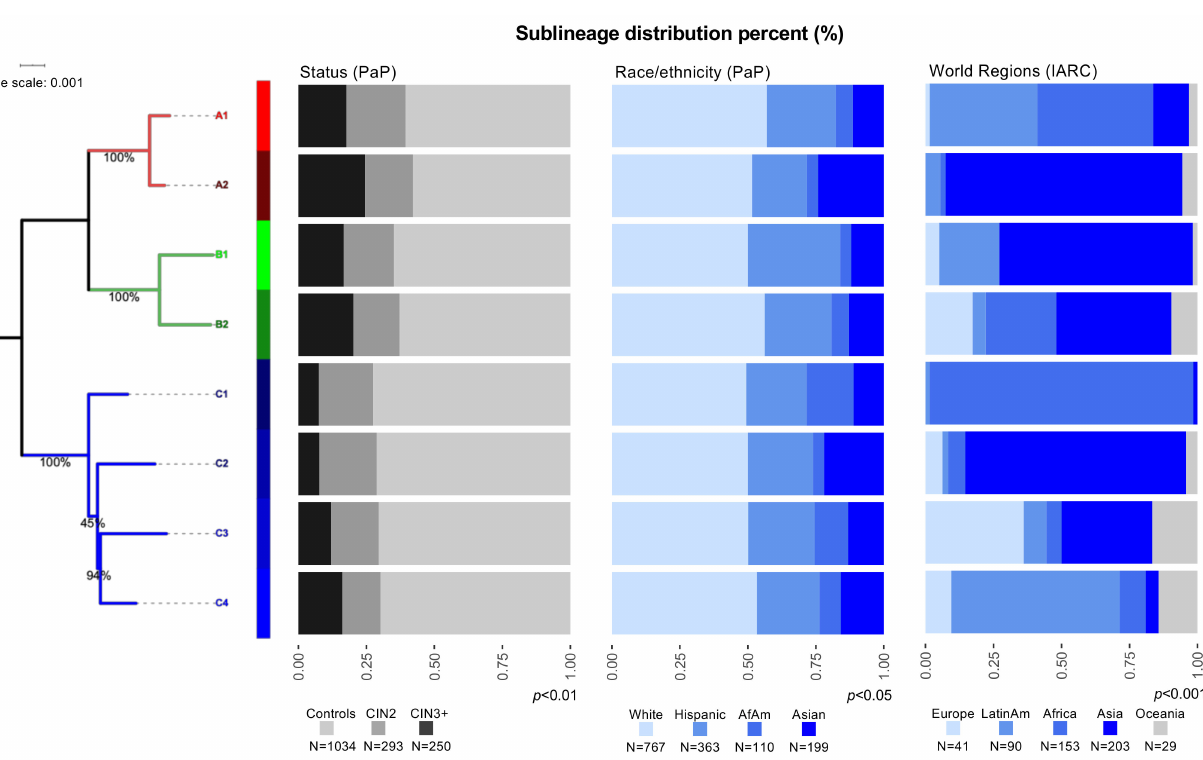
Figure 1. HPV31 phylogenetic tree of lineages and sublineages and the characteristics of each sublineage by case-control status and race/ethnicity are illustrated for the PaP Study and by world region for the IARC collection as indicated.